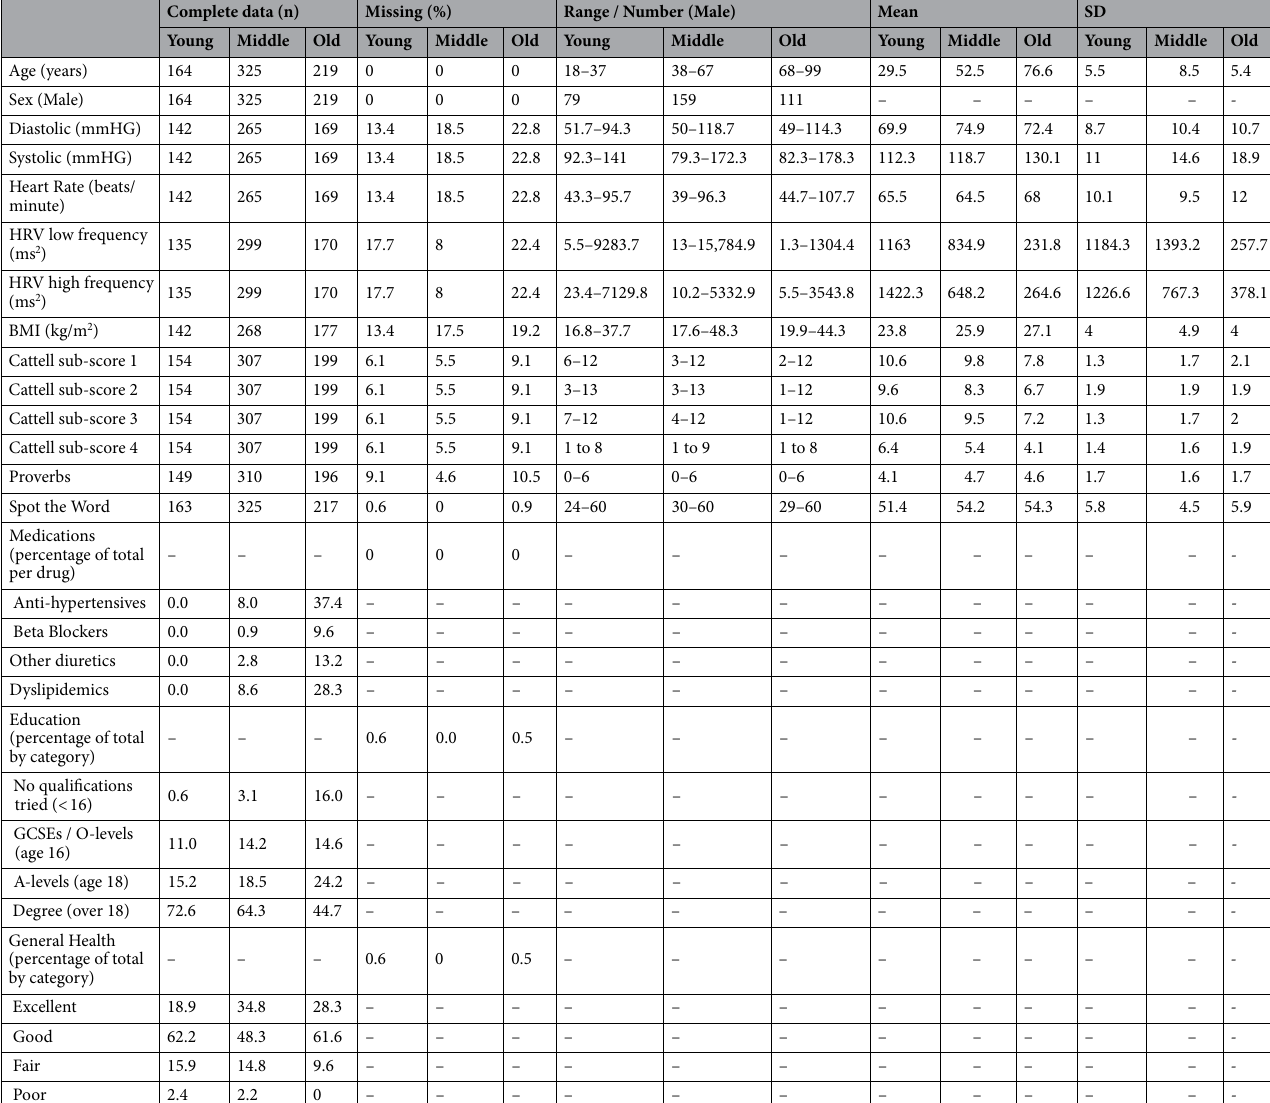
Table 1. Demographic information by age-tertiles (n = 708). For the three observations of systolic, diastolic and heart rate, average values are reported. Measures presented here were averaged over the three observations. One decimal place is reported where data are continuous. BMI body mass index, GCSE The General Certificate of Secondary Education, HRV heart rate variability, SD standard